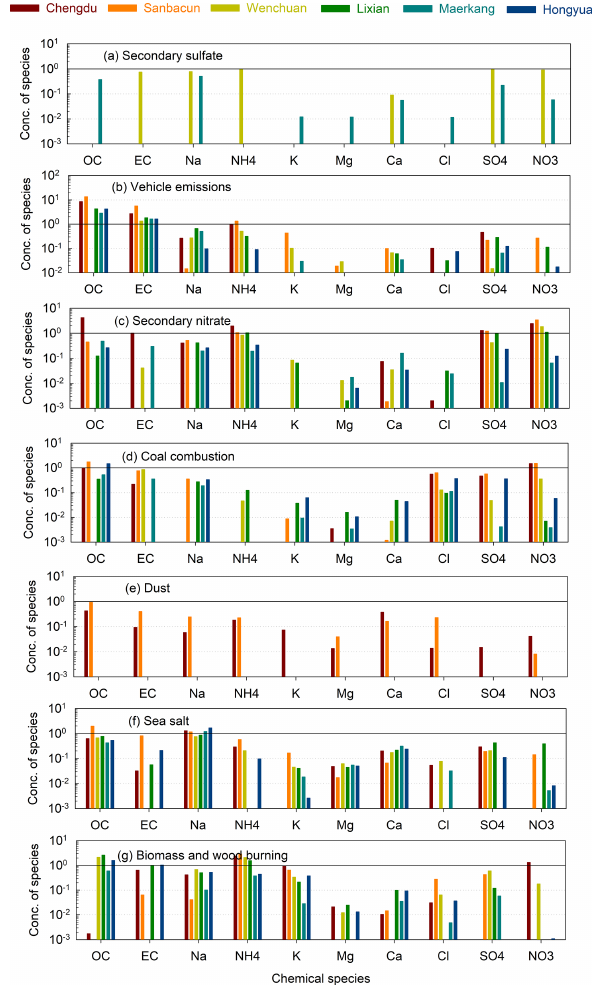
Figure 8. Mass concentrations of species for each source at each site apportioned by PMF model in winter during the campaign. The vertical axes are showed on a logarithmic scale to better distinguish between the concentrations of chemical species among the measure- ment